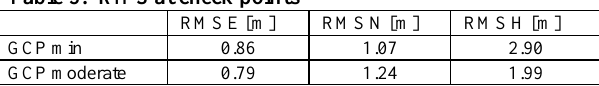
Table 5: RMS at check points